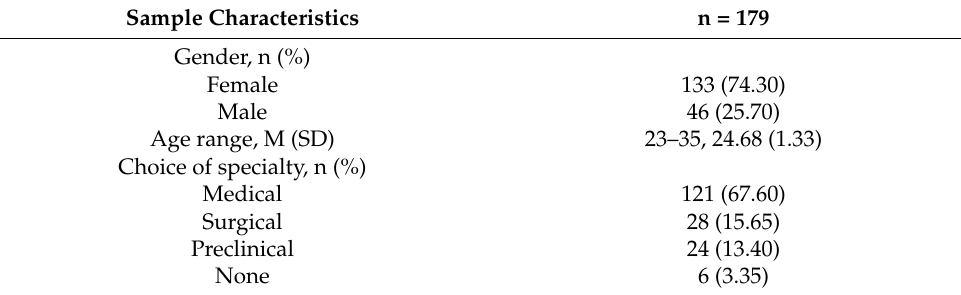
Table 1. Demographic characteristics. Sample